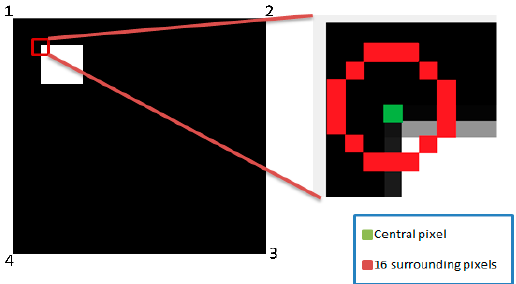
Figure 5. Illustration of the central pixel and 16 surrounding pixels.